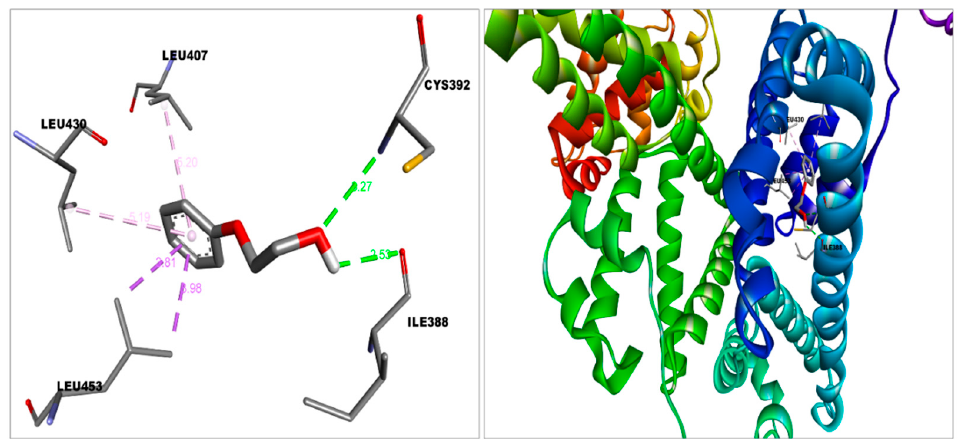
Figure 4. 2-phenoxyethanol docked in HSA’s binding bag.Discovery Studio Visualizer was used to create this figure. (http://accelrys.com/products/collaborative-science/biovia-discovery-studio/visu- alization-download.php).